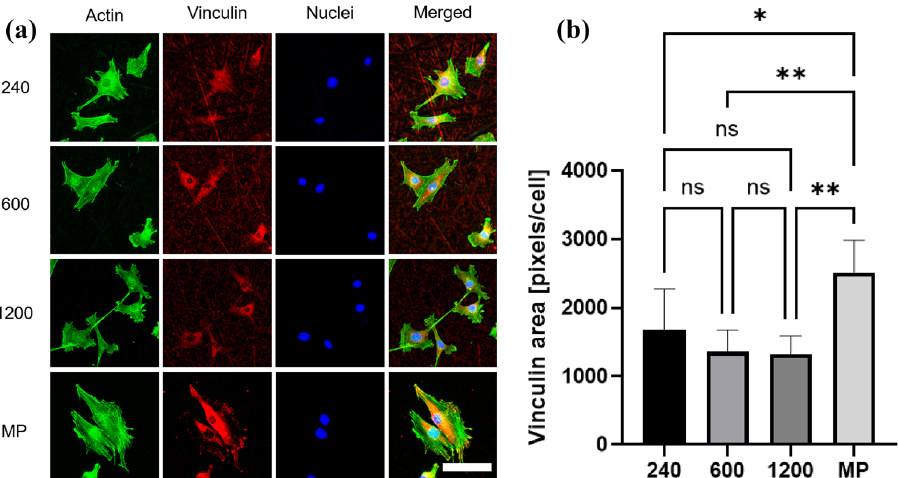
Figure 3. Vinculin expression of cells cultured on Ti with disordered abrasive scratches. Fluorescent microscopic images of F-actin and vinculin ( a ) and image base analysis of vinculin expression ( b ). The scale bar indicated 100 μm, and the data shown are mean ± SD. *p < 0.05; **p < 0.01. ns indicates no significant difference.